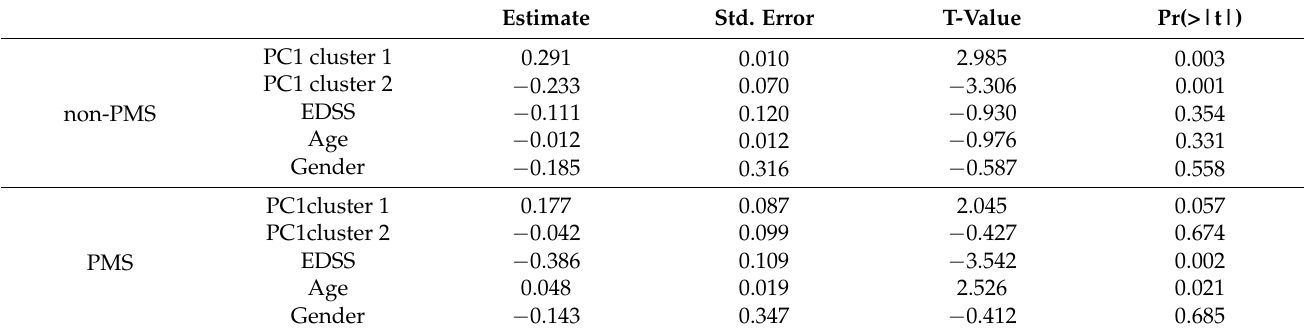
Table 5. Results of the multiple regression analysis for let-7b-5p with EDSS, age and gender in non-PMS and PMS patients. Estimate Std. Error T-Value Pr(>|t|) PC1 cluster 1 0.291 − non-PMS